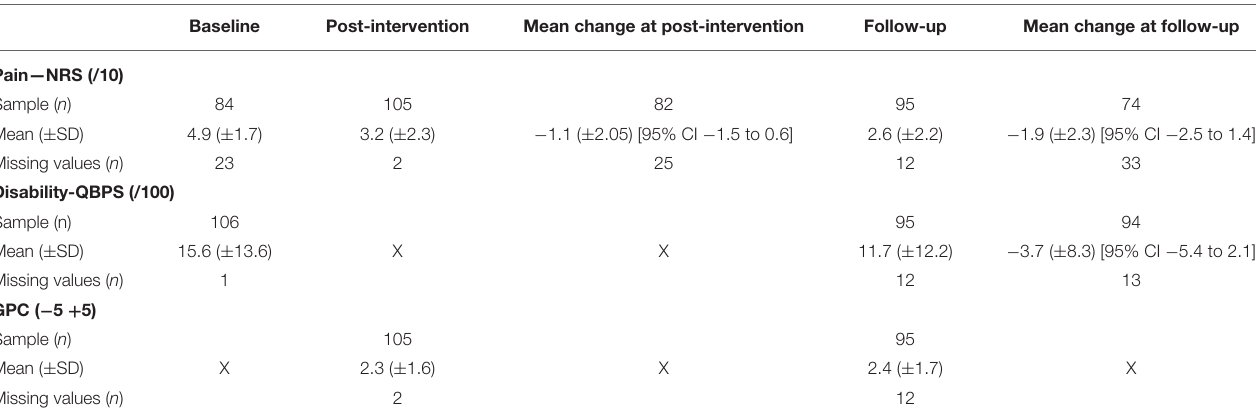
TABLE 3 | Description of outcome